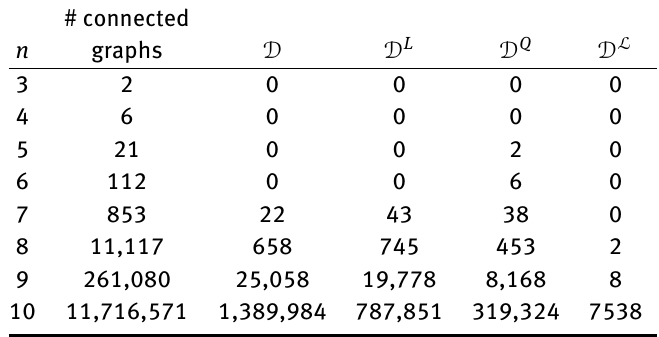
Table 4: Number of connected graphs with a cospectral pair with respect to each matrix. Counts for D , D L , D Q from [3].